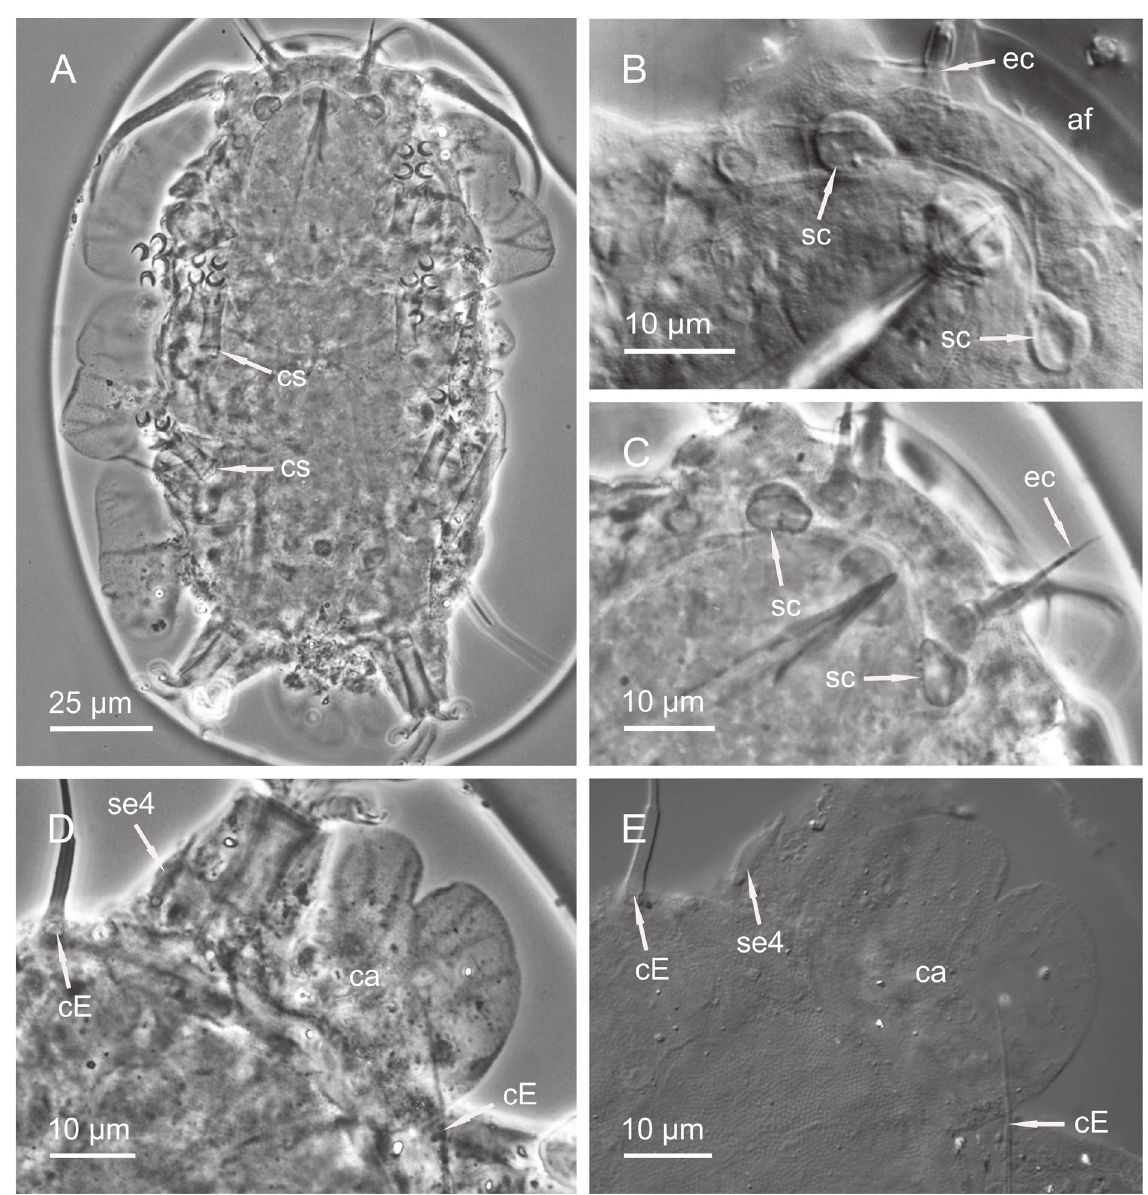
Fig. 15. Micrographs of Higginsarctus laurae gen. et sp. nov., holotype, ♀ (NHMD-293905). A . Overview (PhC). B . Close up on the head (DIC), ventral view showing the secondary clavae. C . Close up on the head (PhC), ventral view showing the secondary clavae. D . Close up on the caudal ala (PhC), dorsal view showing the procuticular ramuli. E . Close up on the caudal ala (DIC), dorsal view showing the epicuticular pillars. Abbreviations: see Material and